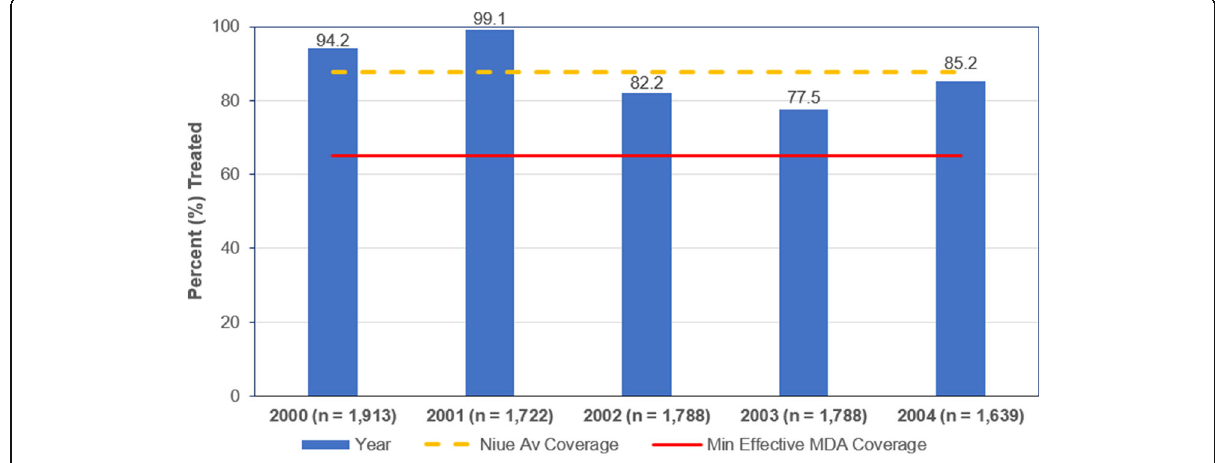
Fig. 5 Annual MDA coverage under PacELF Niue 2000 – 2004. Y -axis, percent (%) treated. Source: Adapted from [22,